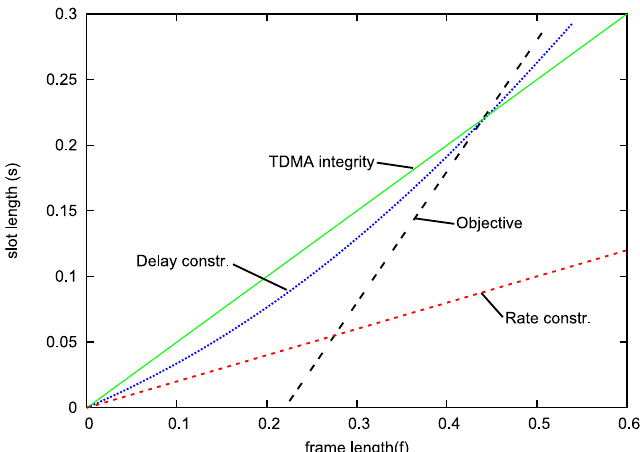
Figure 16. Graphical illustration of the optimization problem for Equal slot sizing (ESS). The feasible region is above the delay constraint and below the TDMA integrity constraint. The rate constraint does not affect the feasible region in this